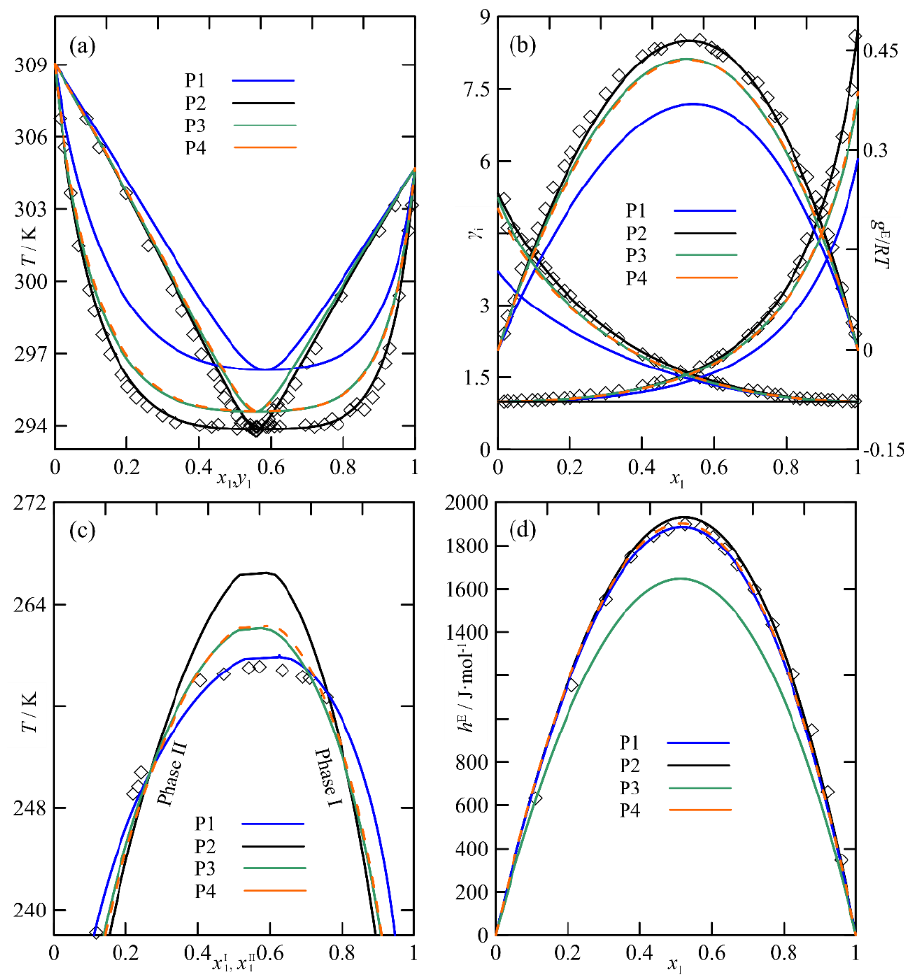
Figure 10. Estimation diagrams by NRTL using the indicated parametrizations: ( a ) VLE: T vs x 1 , or y 1 ; ( b ) γ i or g E / RT vs x 1 ; ( c ) LLE: T vs x I